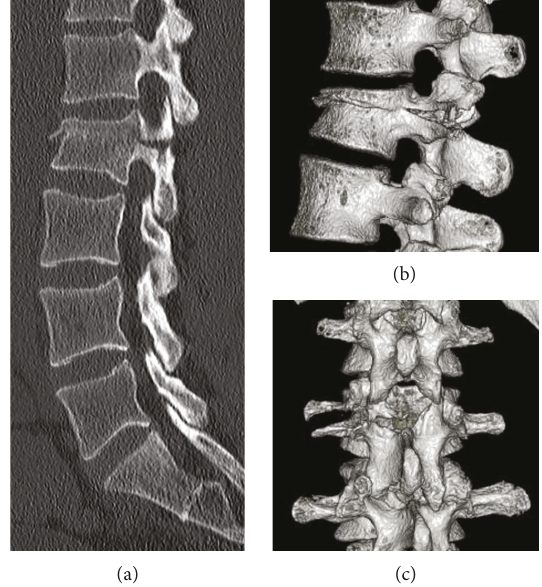
Figure 2: Preoperative computed tomography (CT) of the lumbar spine. (a) Left parasagittal CT showing an L2 fracture involving the vertebral body and extending through the pedicle posteriorly. (b) 3D-CTs from the left lateral view and (c) posterior view show that the fracture consists of horizontal splitting from the vertebra, through the left pedicle and transverse process, and reaching to the mid-upper neural